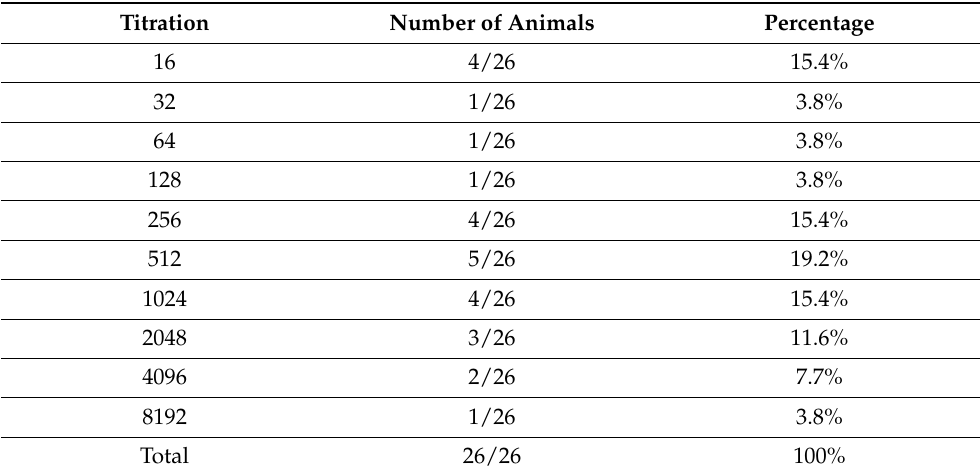
Table 1. Distribution of antibody titration for anti- T. gondii in seropositive cats in the municipality of Rolim de Moura, state of Rond ô nia, North Brazil.